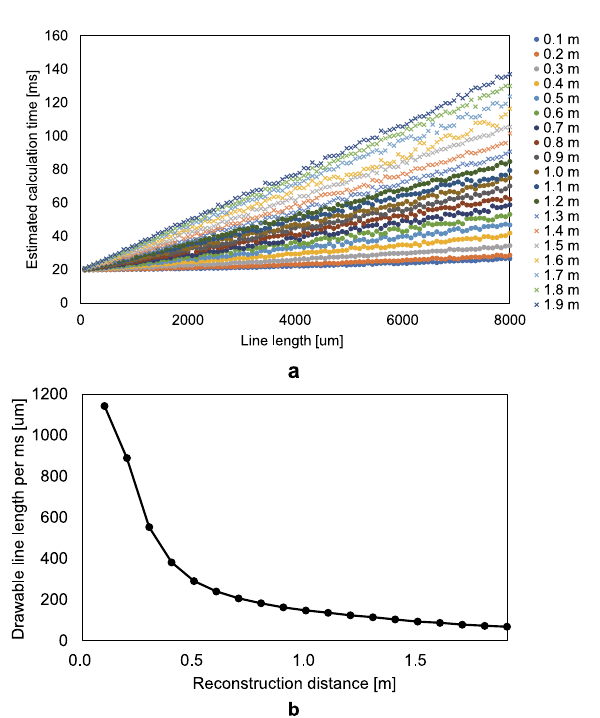
Figure 9. Computational performance of the CG-line method. ( a ) Relation between CGH calculation time and line length. ( b ) Drawable line length per millisecond as a function of the reconstruction